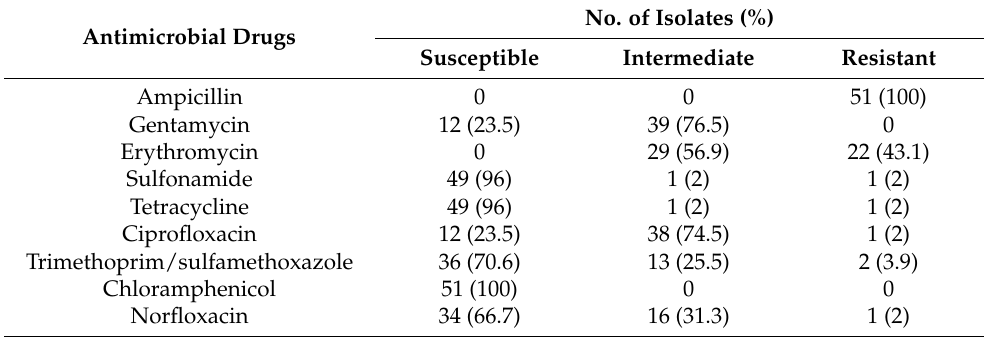
Table 2. Antimicrobial susceptibility patterns of V. parahaemolyticus isolates from seafood sources.